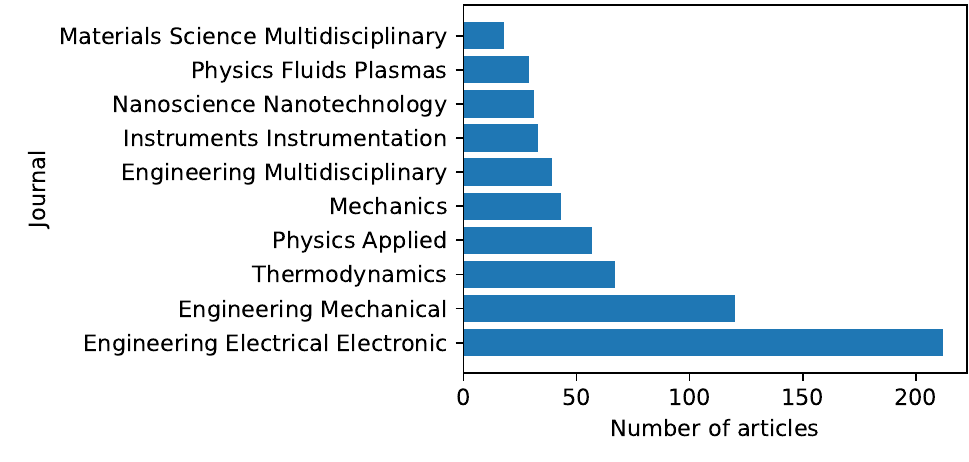
Figure 6. Distribution of accepted